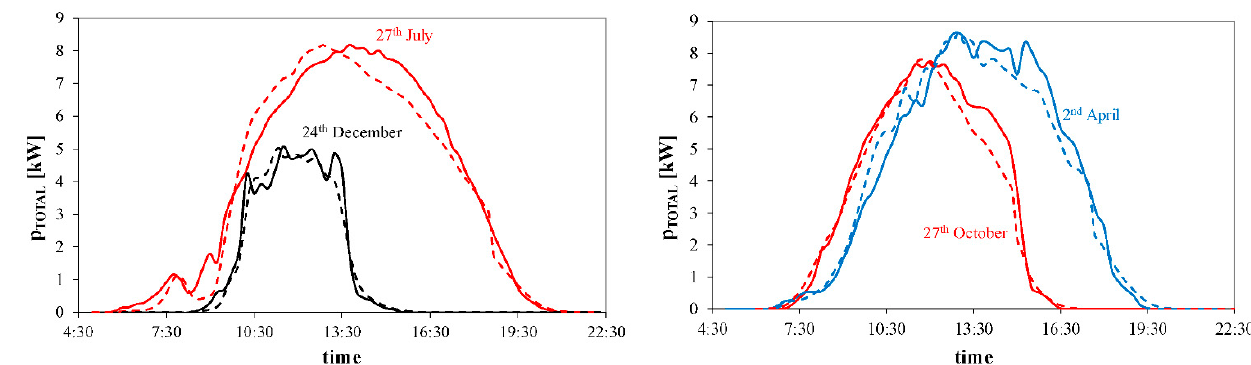
Figure 7. Measured and computed waveforms of the power produced by the investigated photovoltaic installation on selected days .